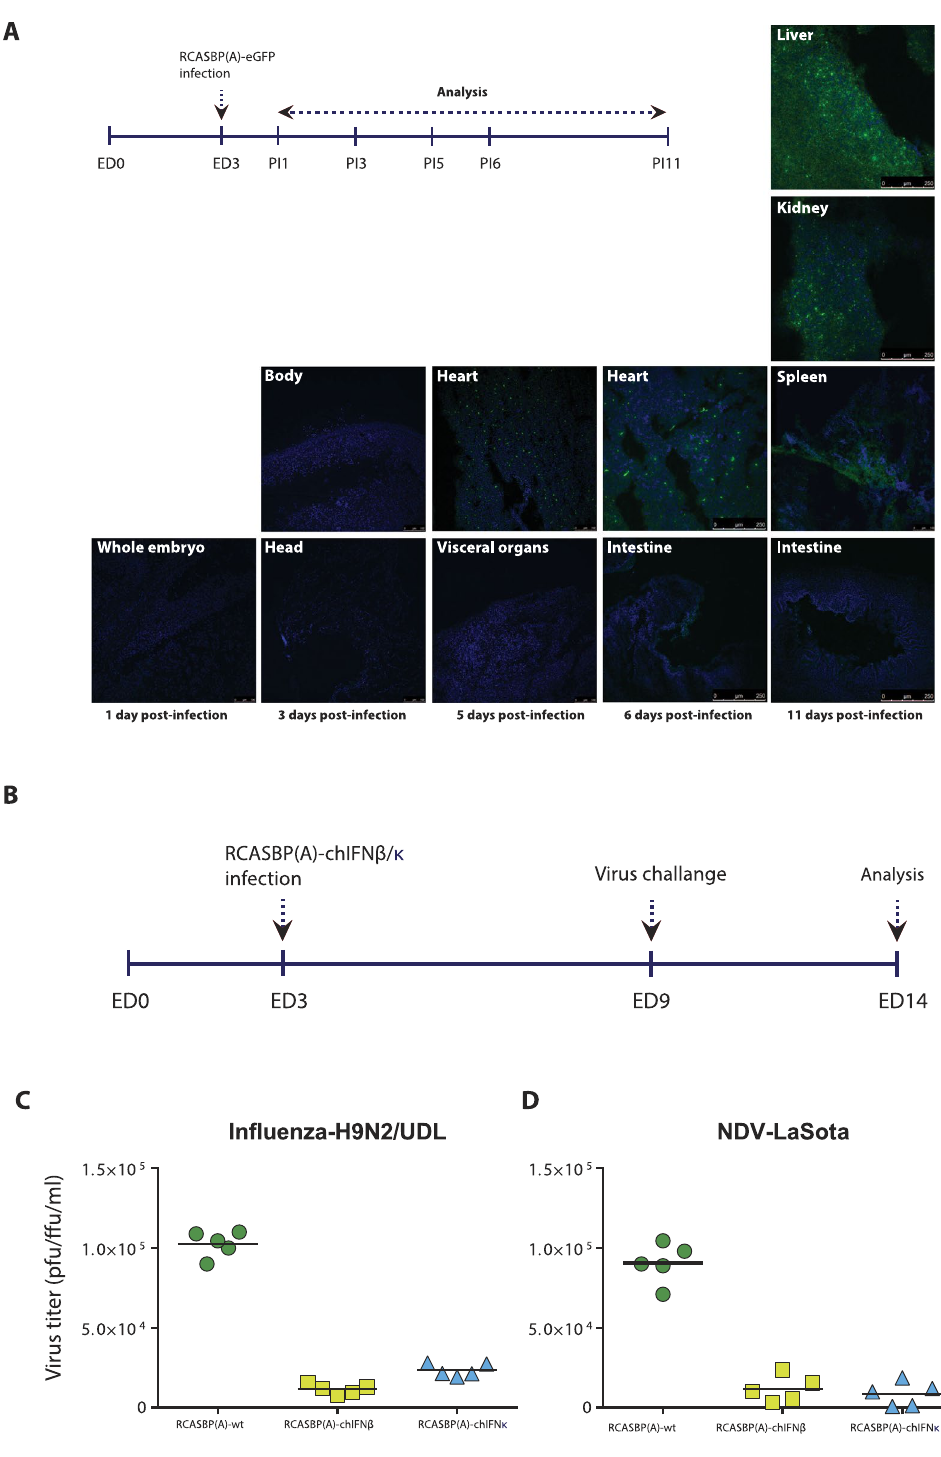
Figure 6. Spatiotemporal expression dynamics of the transgene in developing embryos, and antiviral activity of chIFN- β and chIFN- κ in ovo . ( A ) Using experimental layout, depicted in the schematic illustration in the inset, expression of the GFP reporter gene indicated the embryo-wide distribution. After infection of eggs on third day of embryonation (ED), the expression of the GFP was detected as early as 6 days post-infection (PI) and most organs of the embryos were positive for the transgene at day 11 post-infection. Representative images from each time points are shown, and all images are shown at x40 magnification. ( B ) Experimental layout for the generation of transgenic embryos and analysis of the antiviral effects of IFNs in ovo . ( C) Replication of both influenza and ND viruses was markedly compromised in the allantoic fluids collected from eggs expressing RCASBP(A)-mediated chIFN- β and chIFN- κ compared to RCASBP(A)-wt virus. Each dot, circle or triangle represents individual egg and the cross-lines show the mean in each